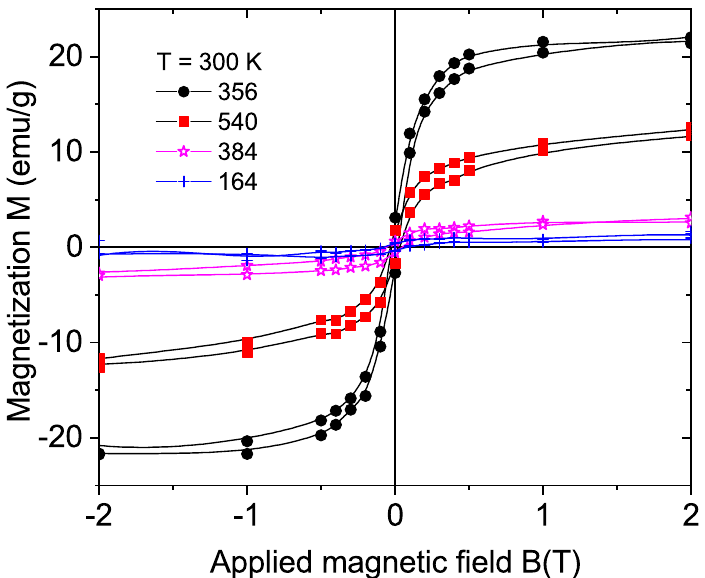
Figure 4. Field hysteresis loops at 300 K of four natural diamond samples ((100) surface, samples 356 and 540; (111) surface, samples 164 and 384). The magnetization values were calculated assuming a ferromagnetic mass given by a 20 nm thick region at the cut surfaces of the